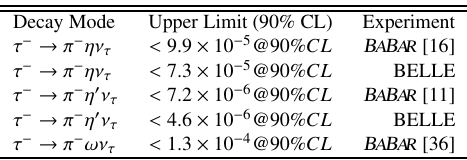
Table 2. Upper limits set on Second Class Currents at